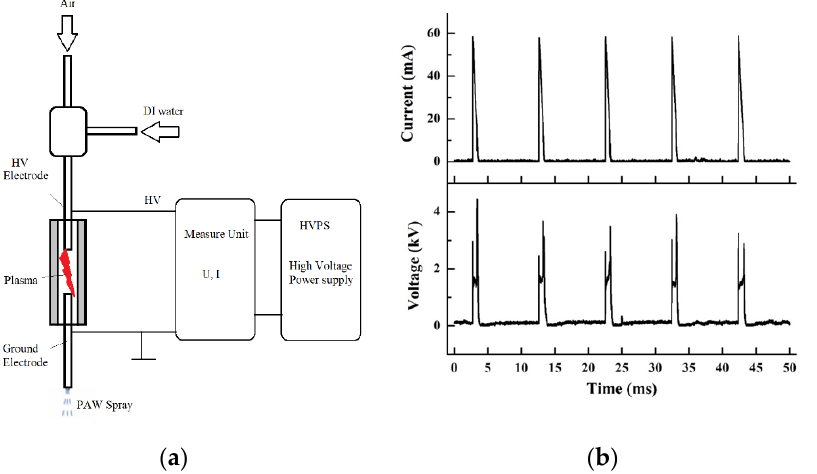
Figure 1. The experimental set - up ( a ) and the current and voltage waveforms ( b ) of the discharge (frequency: 100 Hz, pulse width: 2 ms, distilled water flow: 15 mL/min, air flow: 1.5 L/min).